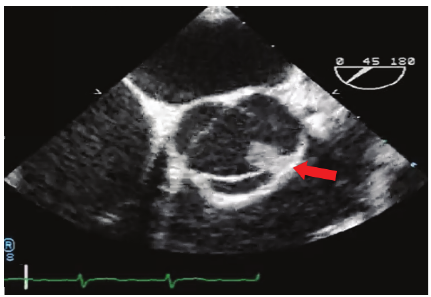
Figure 1: Transesophageal echocardiograph illustrating large, pap- illary, solid, fixed mass, measuring 7 × 7mm on the left coronary cusp, on the left ventricular aspect of the aortic valve.